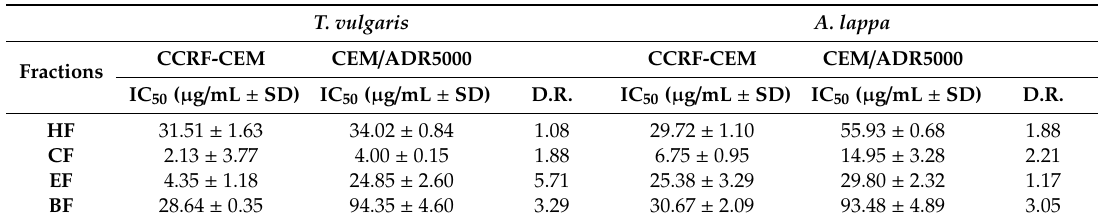
Table 2. Cytotoxicity of di ff erent T. vulgaris and A. lappa fractions towards leukemia cell lines as determined by resazurin